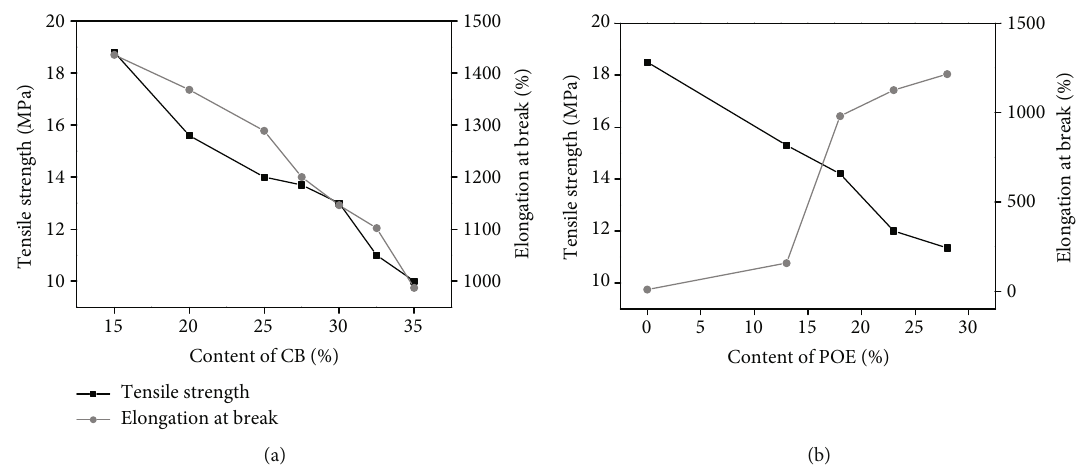
Figure 6: The POE content was fi xed at 18 wt.%, (a) shows the tensile properties of HDPE/POE/CB with various CB content; the CB content was fi xed at 30 wt.%, (b) shows the tensile properties of HDPE/POE/CB (30 wt.%) with various POE